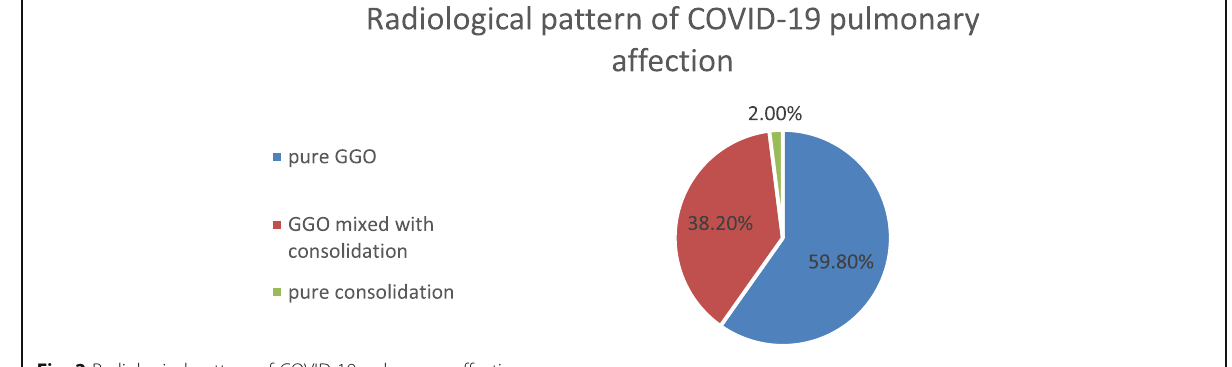
Fig. 2 Radiological pattern of COVID-19 pulmonary